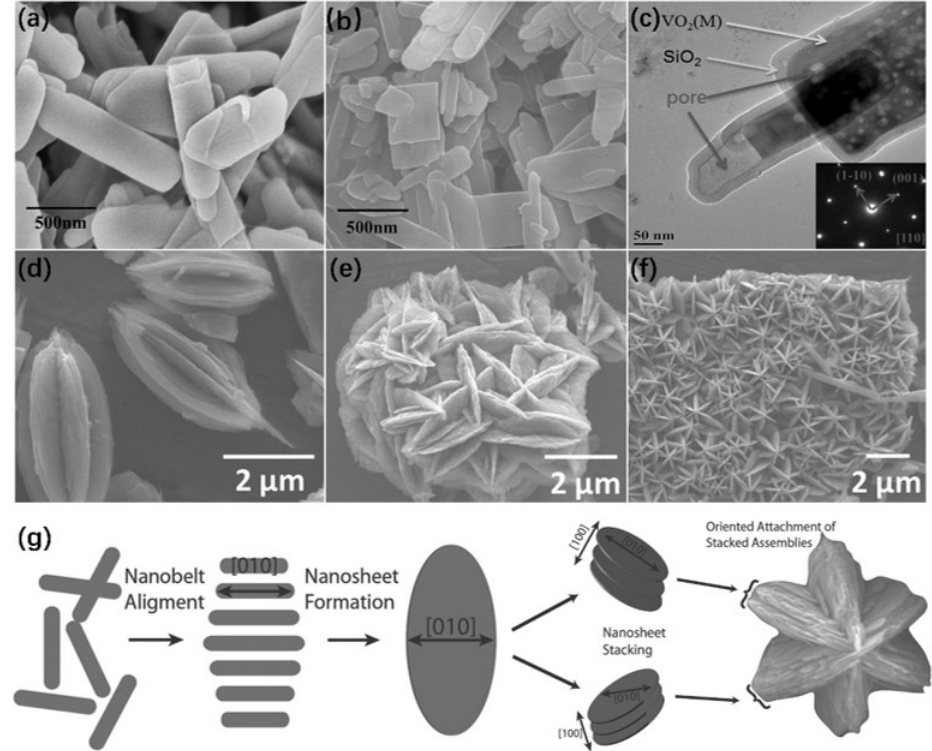
Figure 5. ( a ) SEM image of VO 2 (B)@SiO 2 NPs. ( b ) SEM image of VO 2 (M) annealing from VO 2 (B). ( c ) TEM image of VO 2 (M)@SiO 2 ; the inset in ( c ) is the corresponding SAED pattern. Reproduced from [58], with permission from Elsevier, 2013. ( d – f ) Representative individual mesocrystal assem- blies and an overall SEM micrograph of a typical specimen. ( g ) Schematic diagram of the formation mechanism of VO 2 (B) mesocrystals. Reproduced from [59], with permission from John Wiley and Sons,